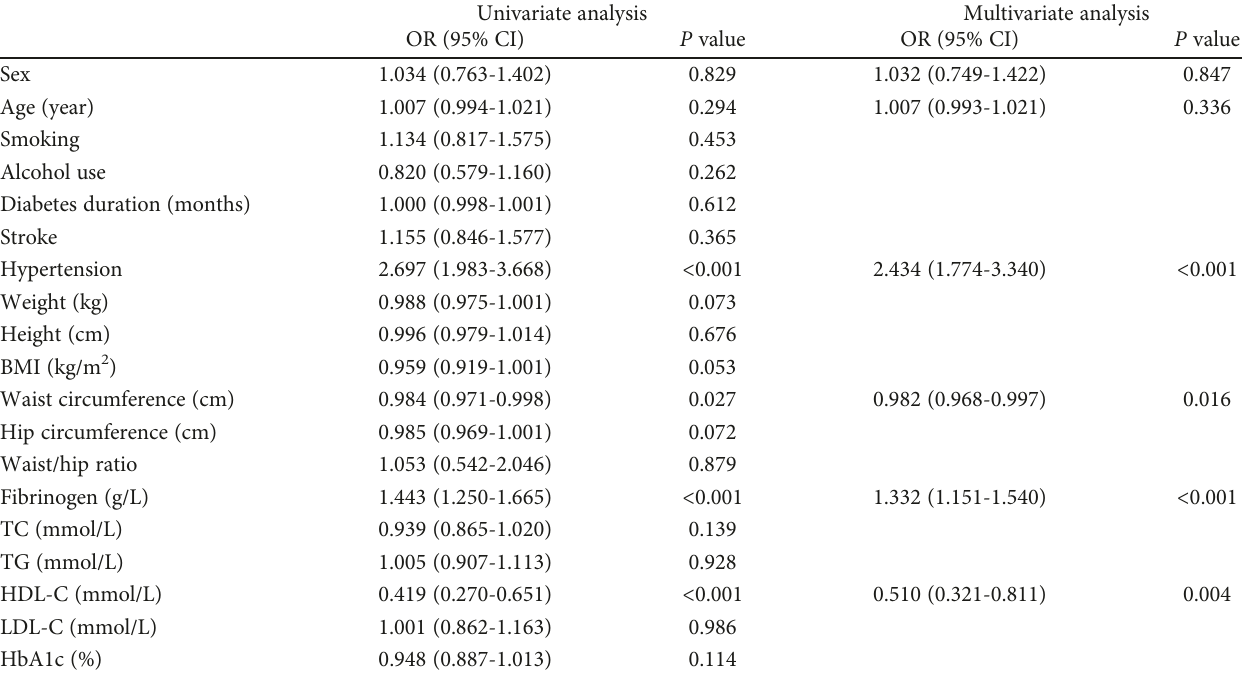
Table 3: Univariate and multivariate analysis of risk factors for PAD.